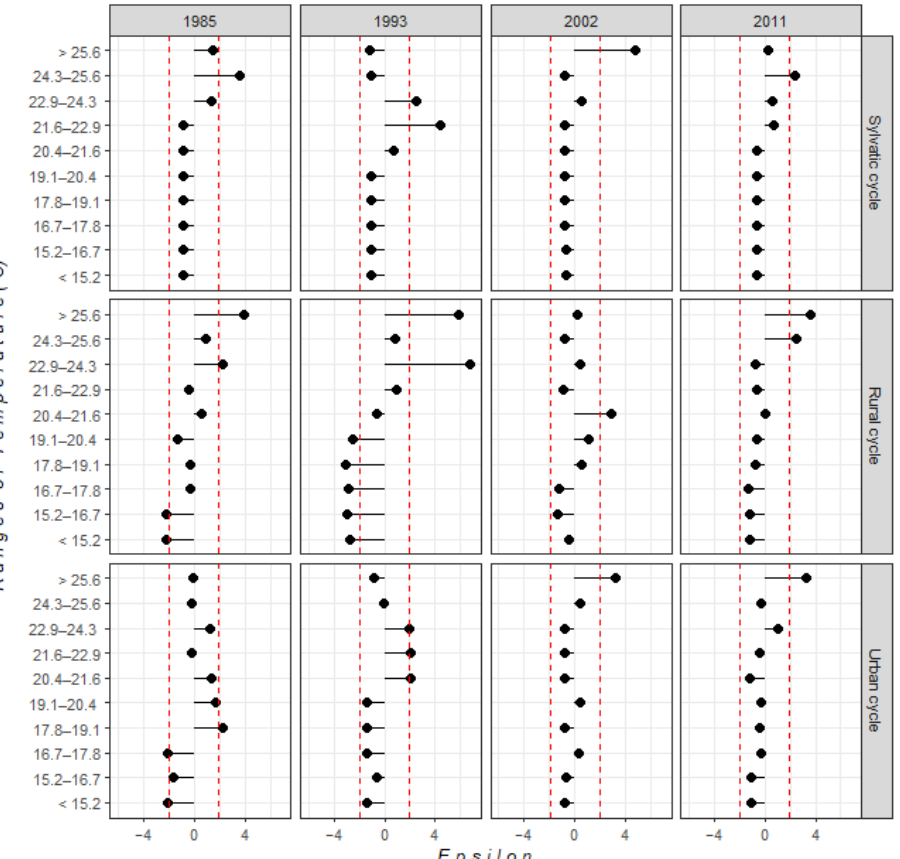
Figure 2. Statistical relationship between each temperature range and each T. cruzi transmission cycle, based on ε -values. The red dotted line indicates confidence intervals of statistically significant correlations (i.e., | ε | > 1.96).